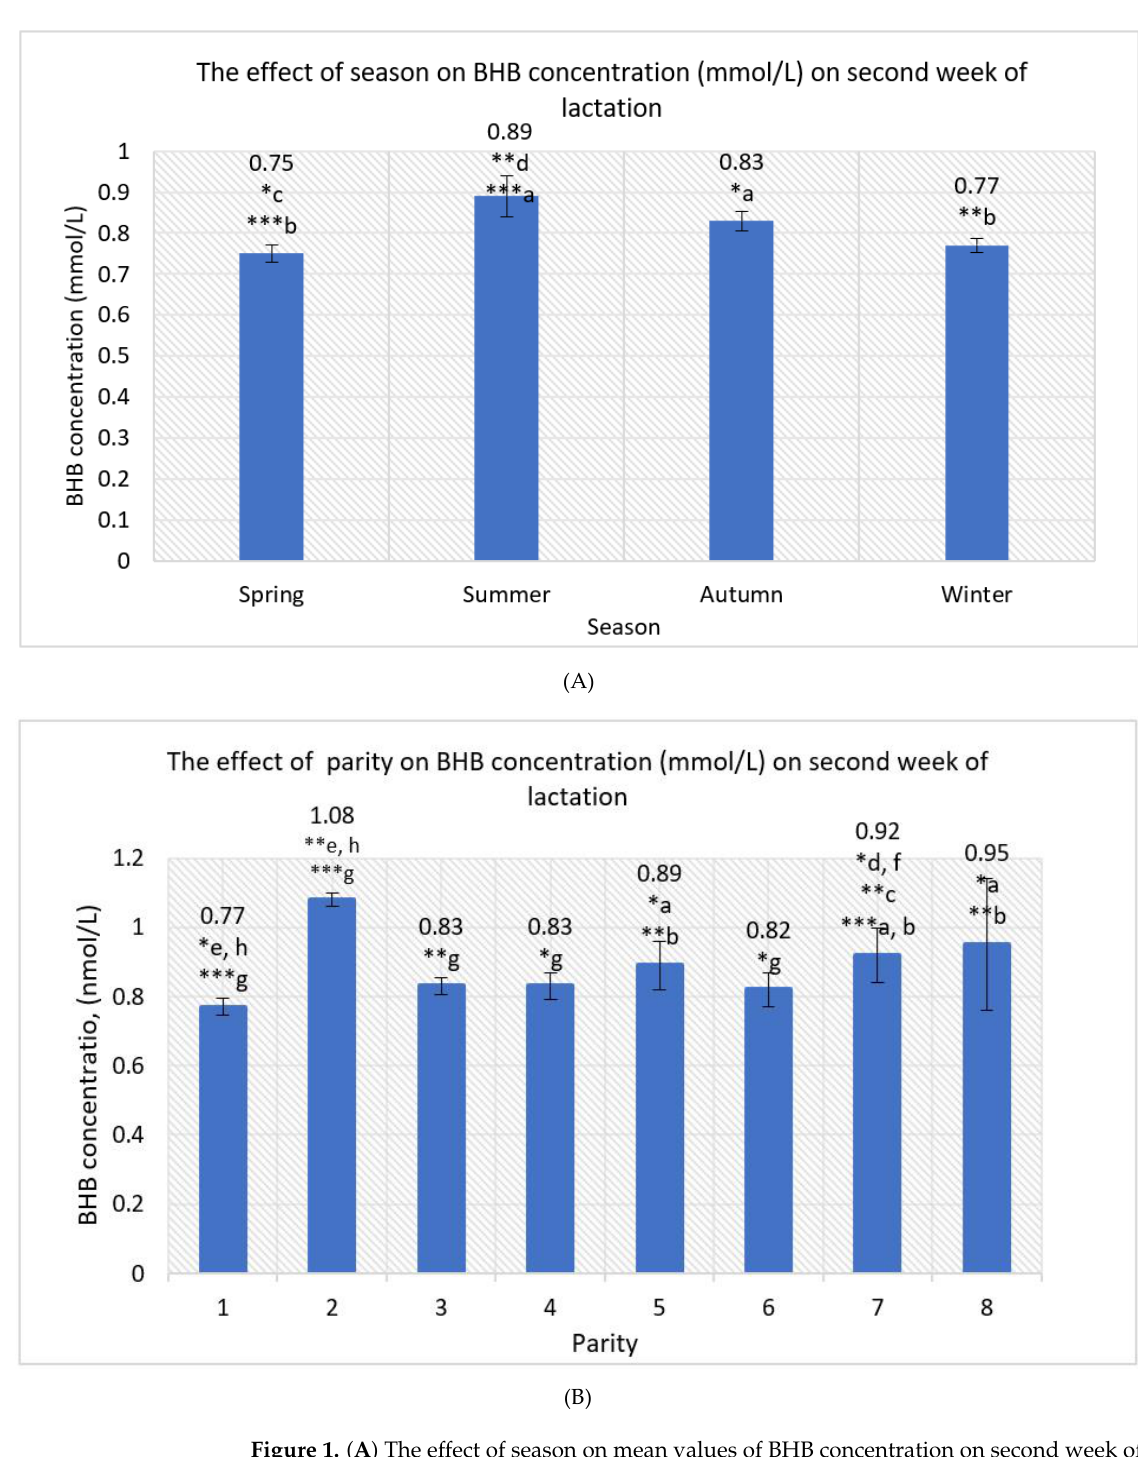
Figure 1. ( A ) The effect of season on mean values of BHB concentration on second week of lactation (mmol/L). a, b, c, d — marking with different letters indicates the mean differences between seasons (spring, summer, autumn, and winter). *** p < 0.001; ** p < 0.01; * p < 0.05. ( B ) The effect of parity on BHB concentration (mmol/L) on second week of lactation. a, b, c, d, e, f, g, h — marking with different letters indicates mean differences between the investigated indicators. *** p < 0.001; ** p < 0.01; * p < 0.05.